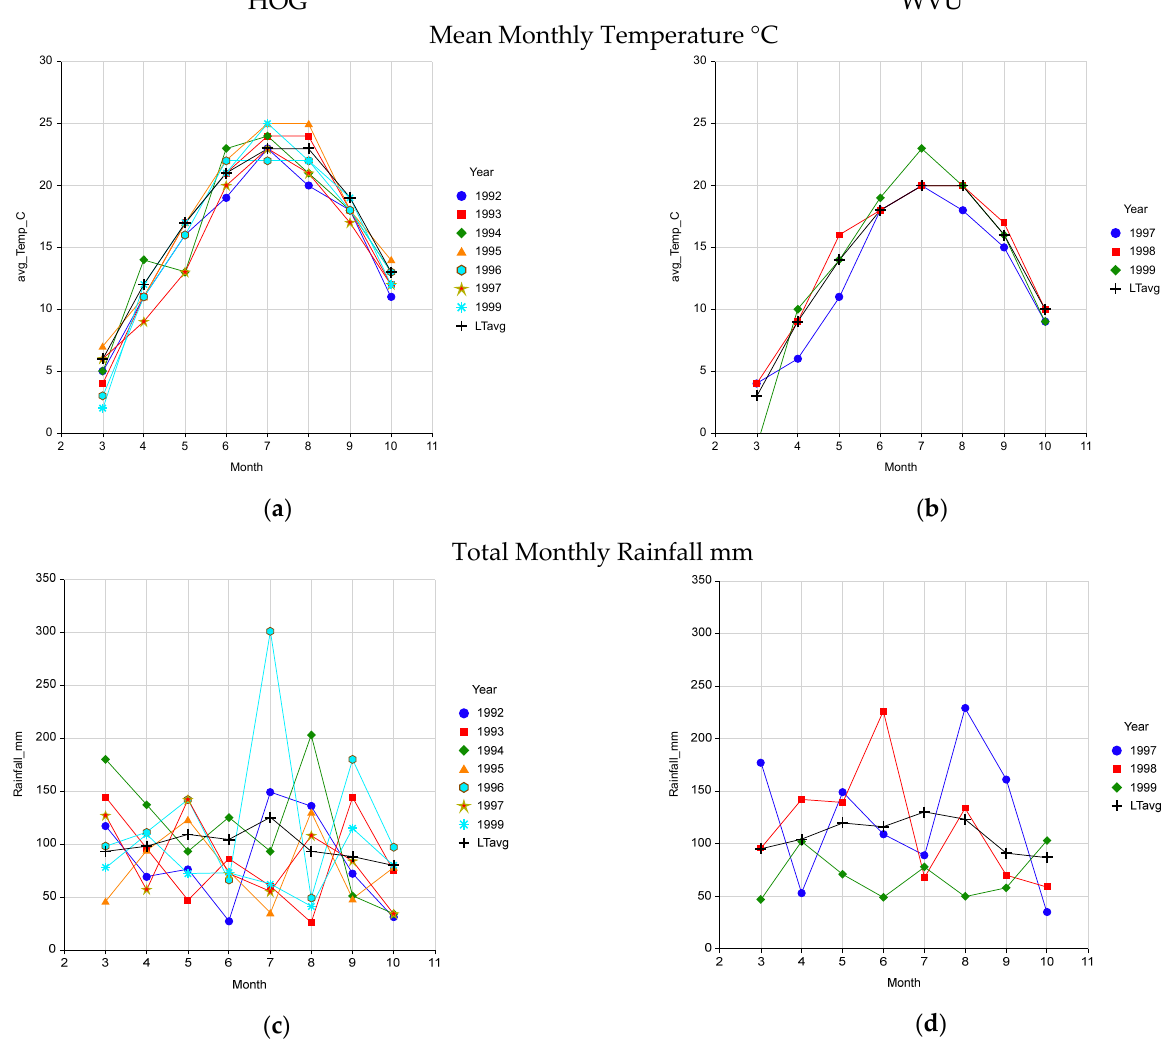
Figure 3. Mean monthly air temperature at the HOG ( a ) and WVU ( b ) sites and total monthly rainfall and long tern averages (LTavg) for these weather components at the HOG ( c ) and WVU ( d ) sites used to validate the pasture growth model.